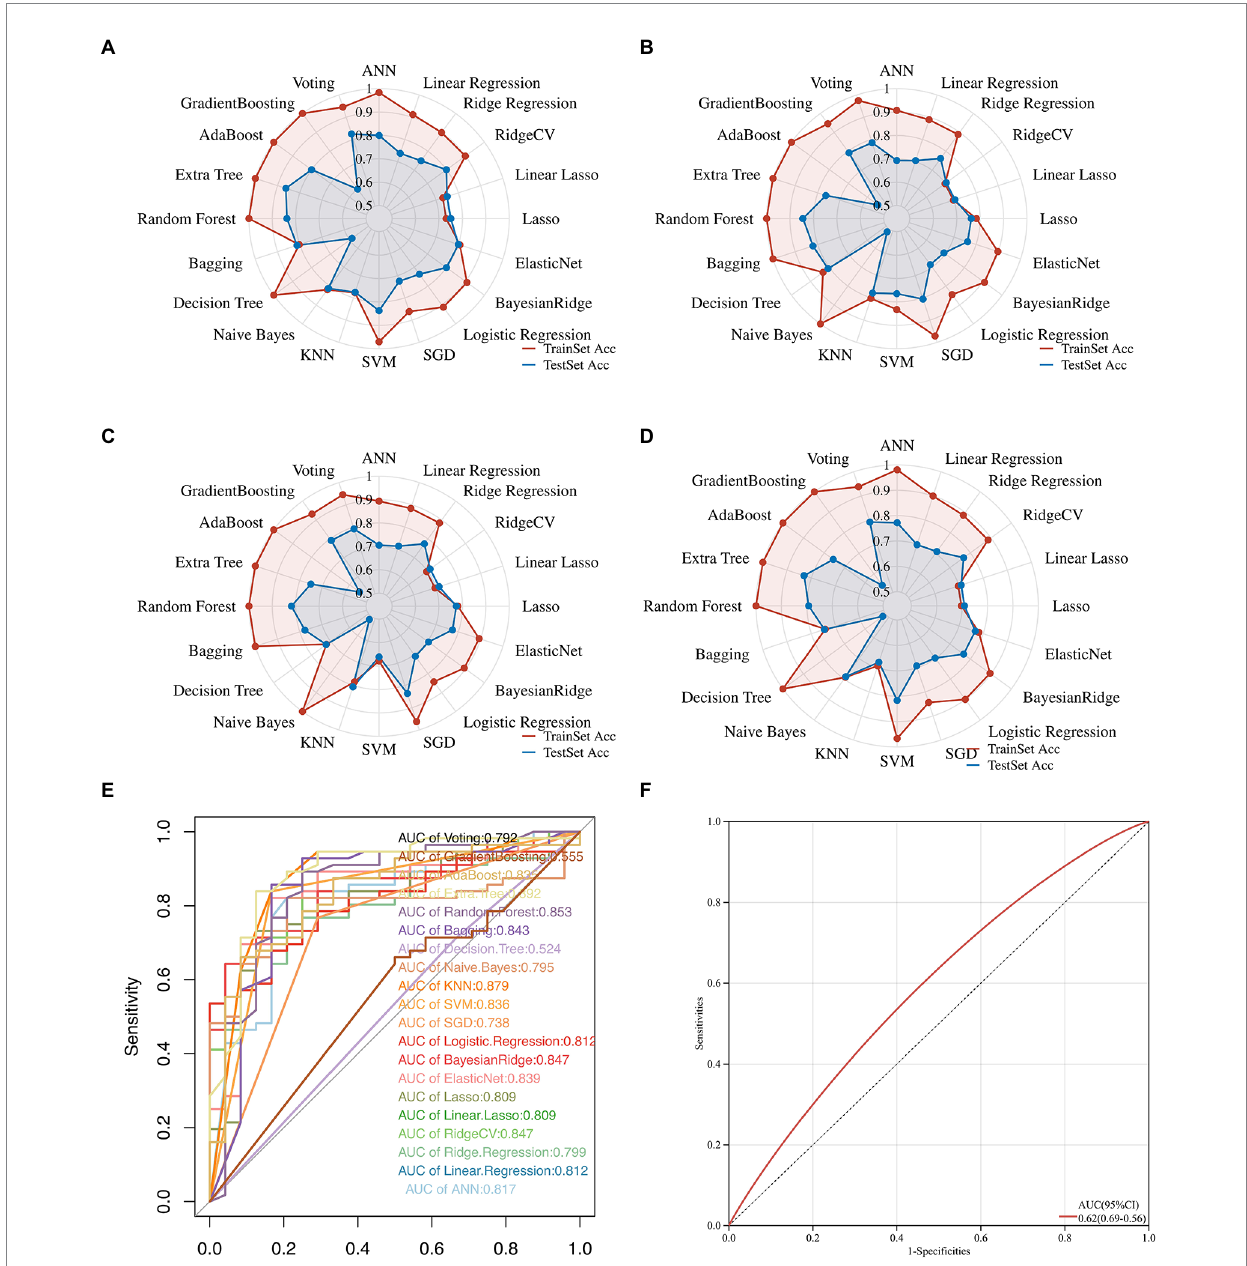
FIGURE 3 Multifaceted evaluation of 20 mainstream machine-learning diagnostic predictors. (A–D) The Radar plot demonstrates accuracy, recall, and F1-score measurement in the train and test sets, respectively. (E) Receiver Operative Curve (ROC), in which each predictor’s Area Under Curve (AUC) value was compared. Generally, an AUC value over 0.7 was considered a good predictive performance. (F) ROC of the cardiac